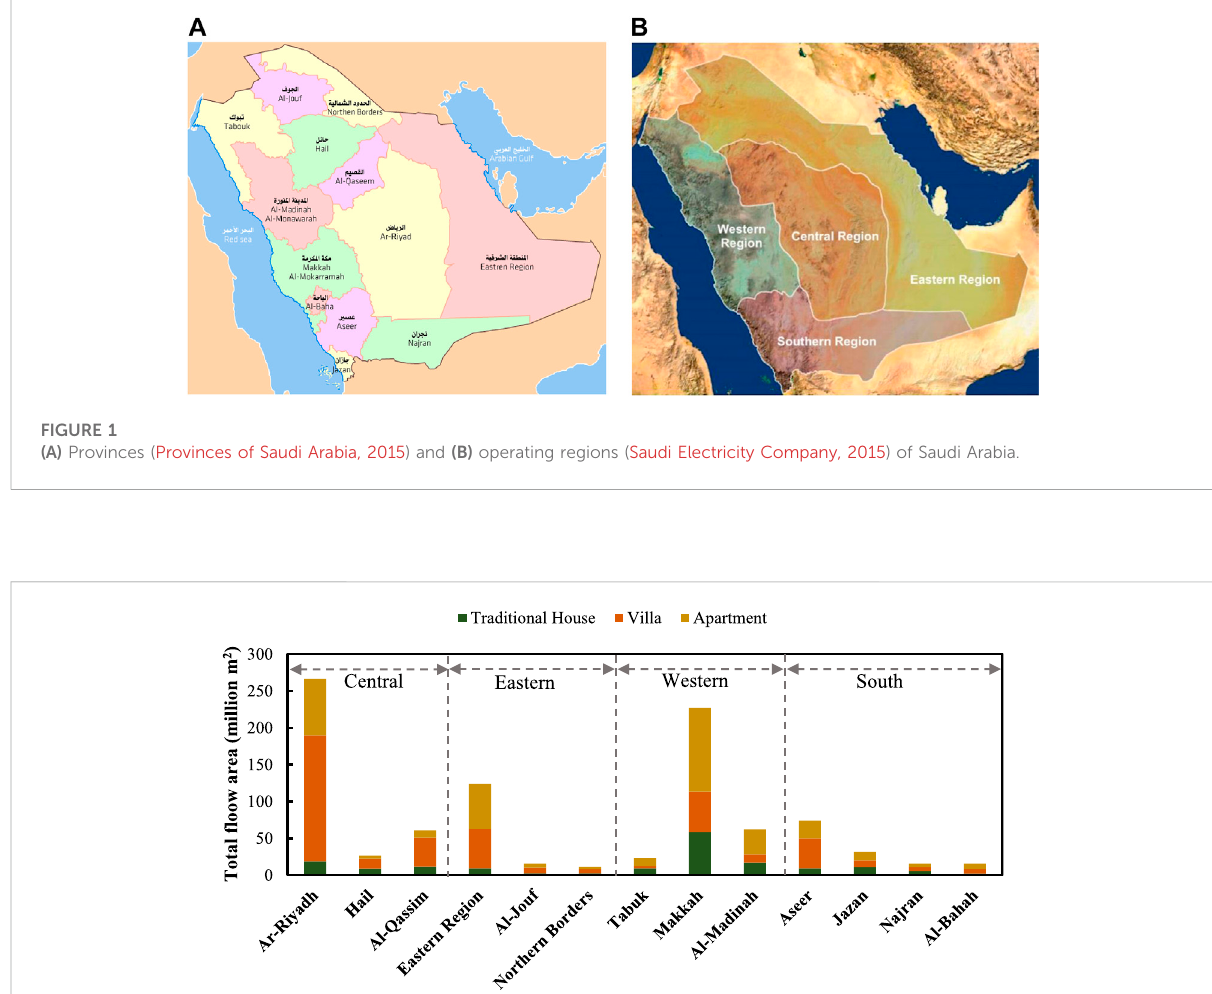
FIGURE 2 Total fl oor area per housing type in different provinces of Saudi